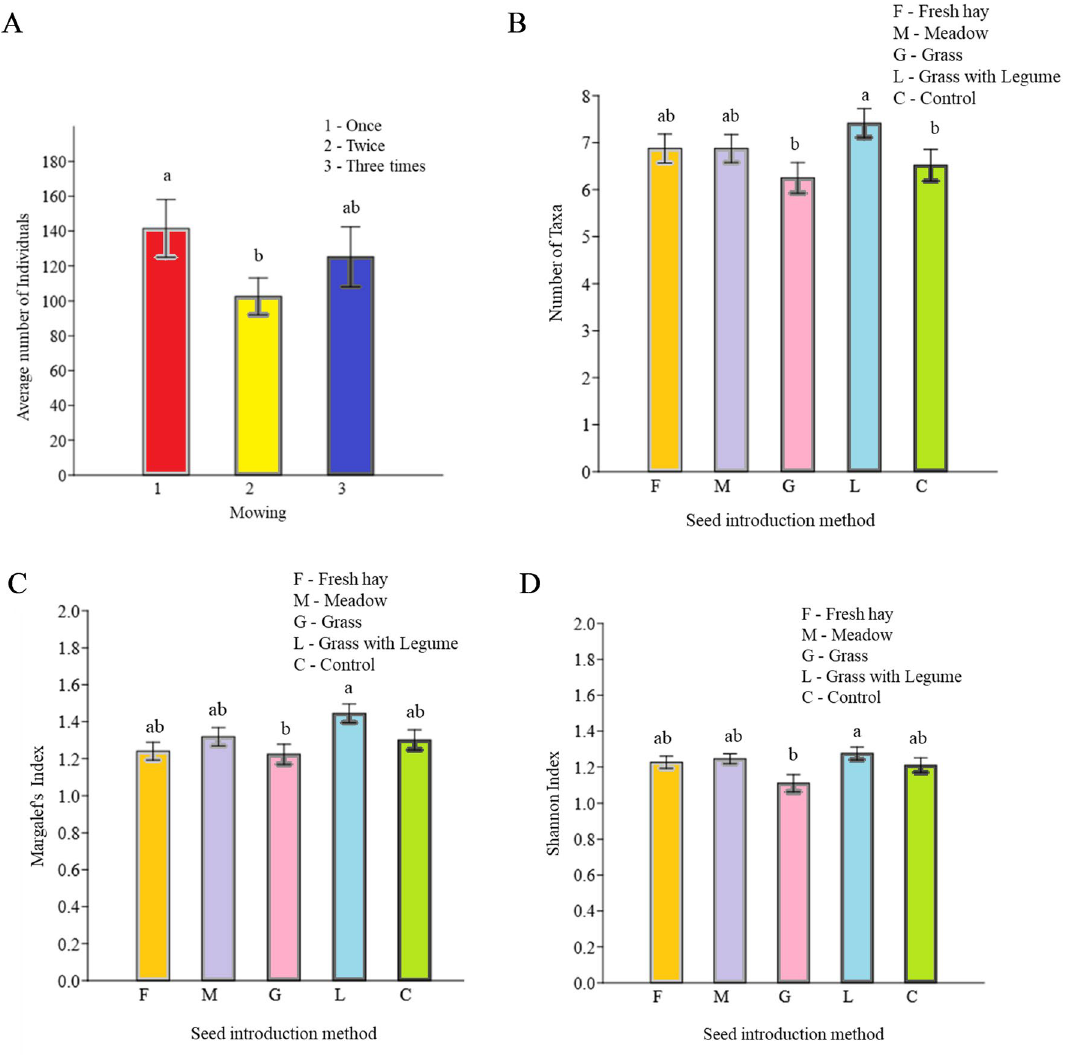
Figure 2. The effects of mowing and seed introduction methods on the community indices of soil invertebrates and their demographic responses. The different lowercase letters indicate significant differences between treatments, p ≤